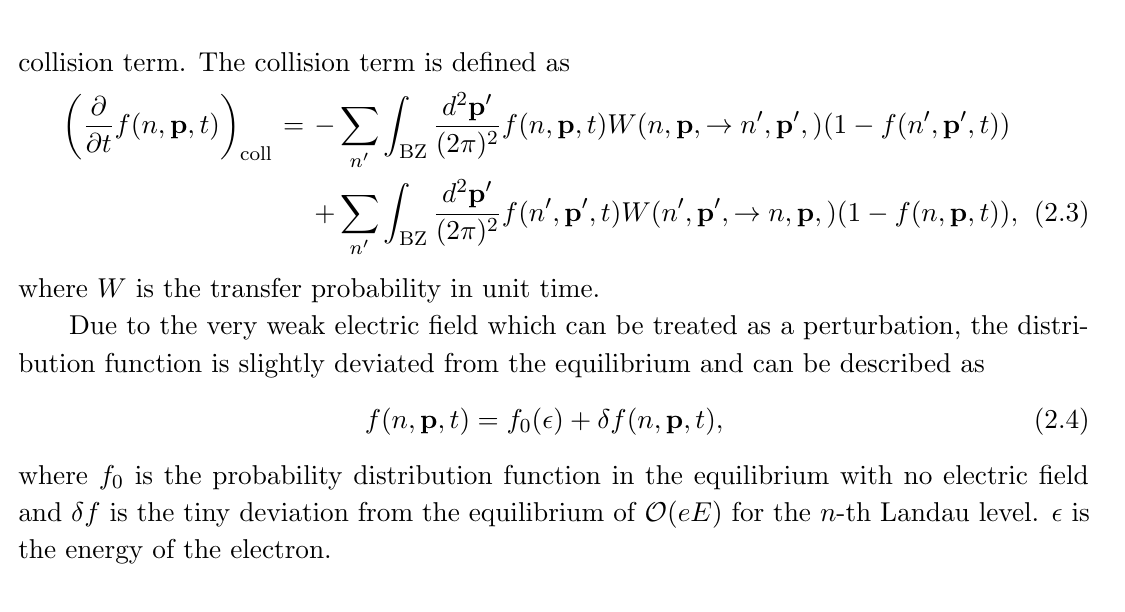
Figure 2 . The mechanisms of the intra-cone transition due to (a)the mass and (b)the (cid:12)rst excited states in a weak magnetic (cid:12)eld region. The e(cid:11)ect of the intra-cone transition can be estimated in the low energy e(cid:11)ective